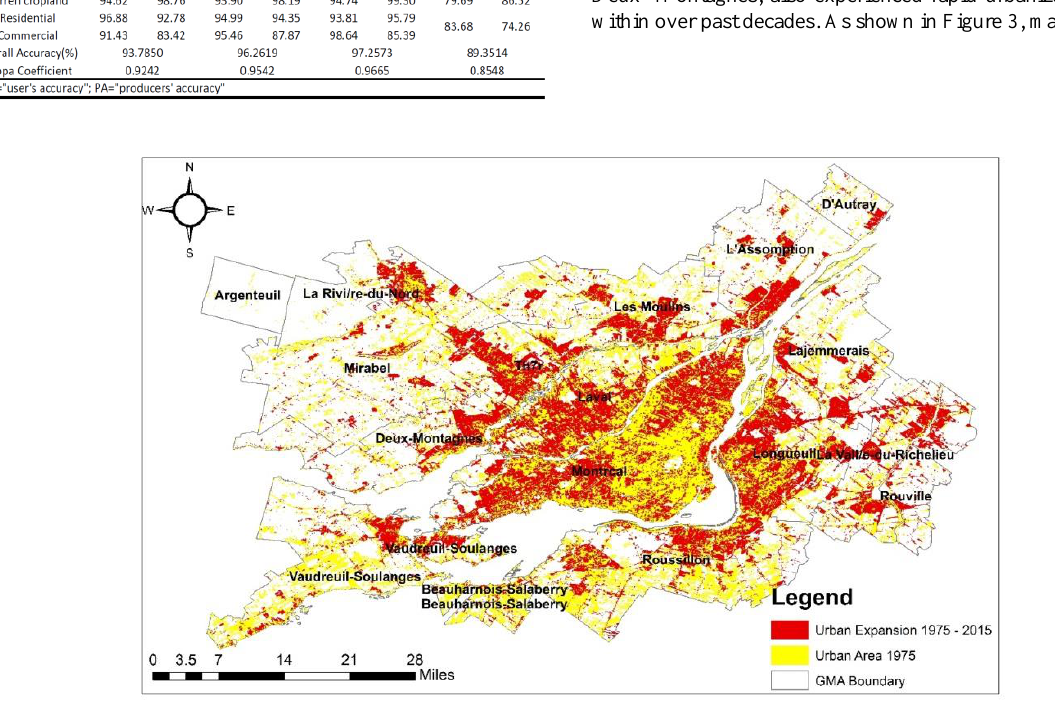
Fig. 2 . Urbanization process change map for the Montréal CMA from 1975 to